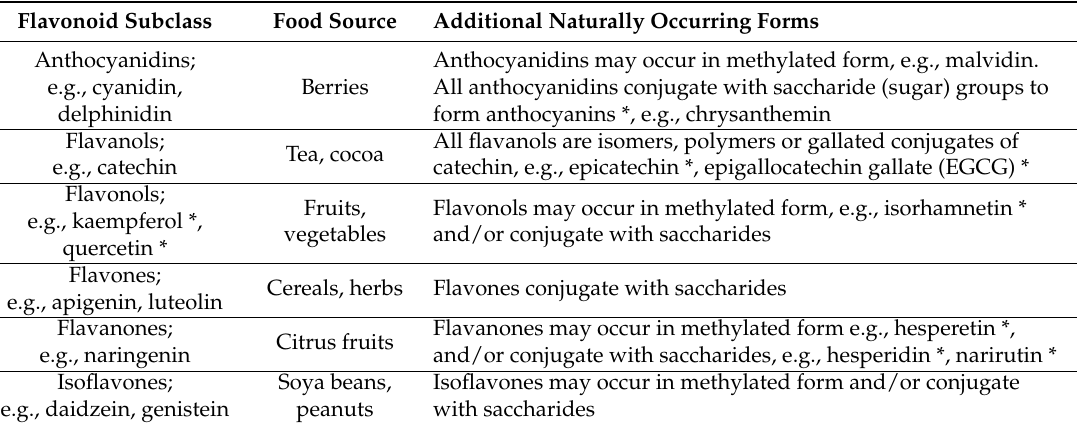
Table 1. Flavonoid subclasses and their naturally occurring